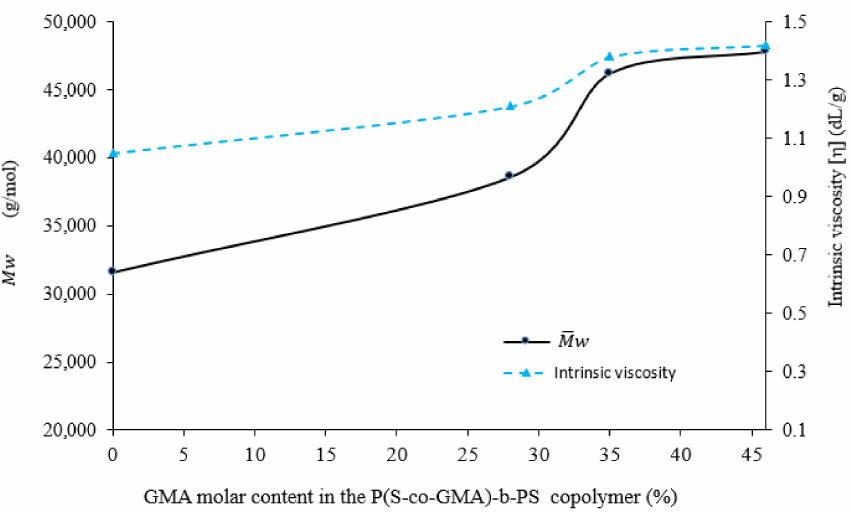
Figure 8. Intrinsic viscosity and M w for rPLA and bPLA